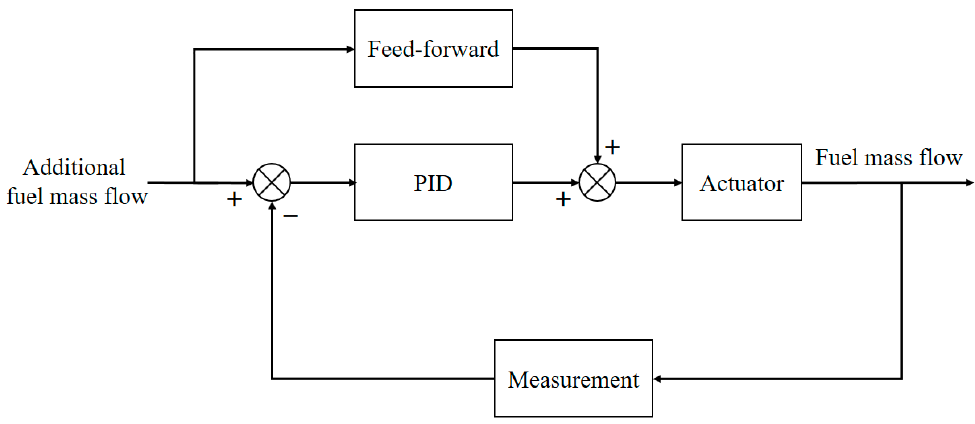
Figure 3. Schematic diagram of the afterburning control structure.